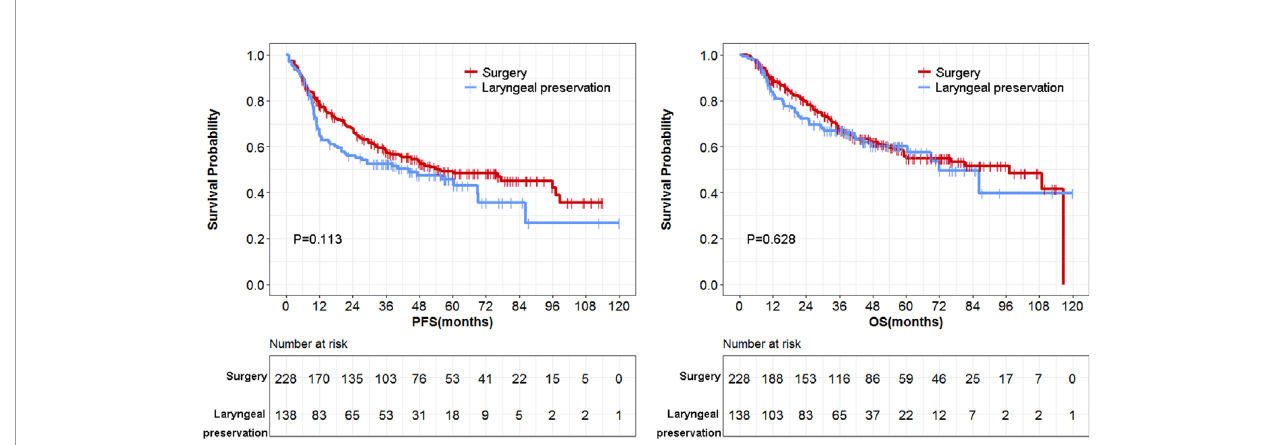
FIGURE 3 | Comparison of overall survival data between surgery and larynx preservation